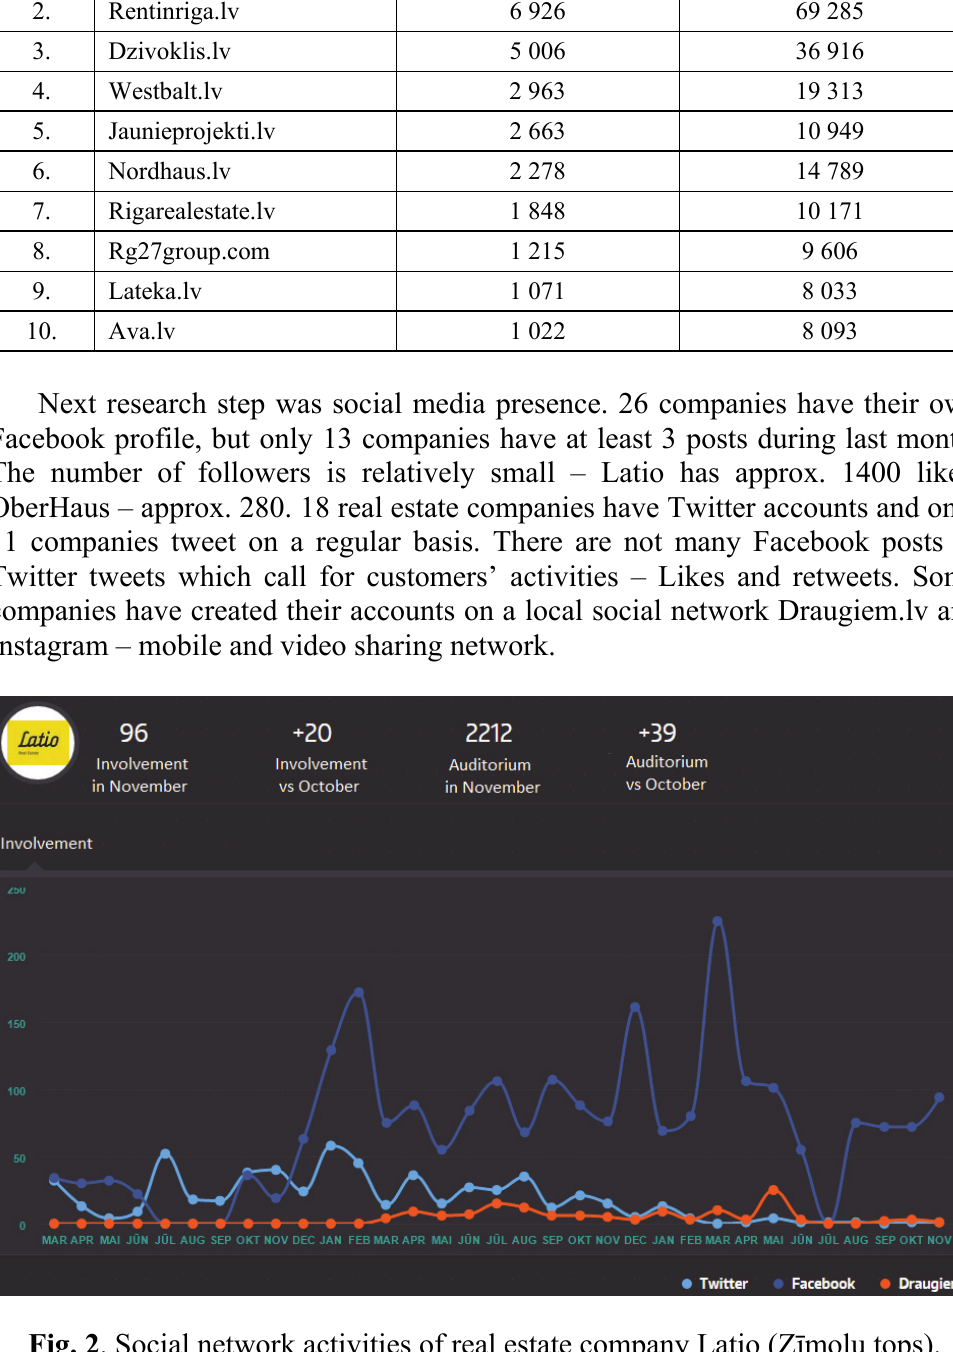
Fig. 2 . Social network activities of real estate company Latio (Zīmolu